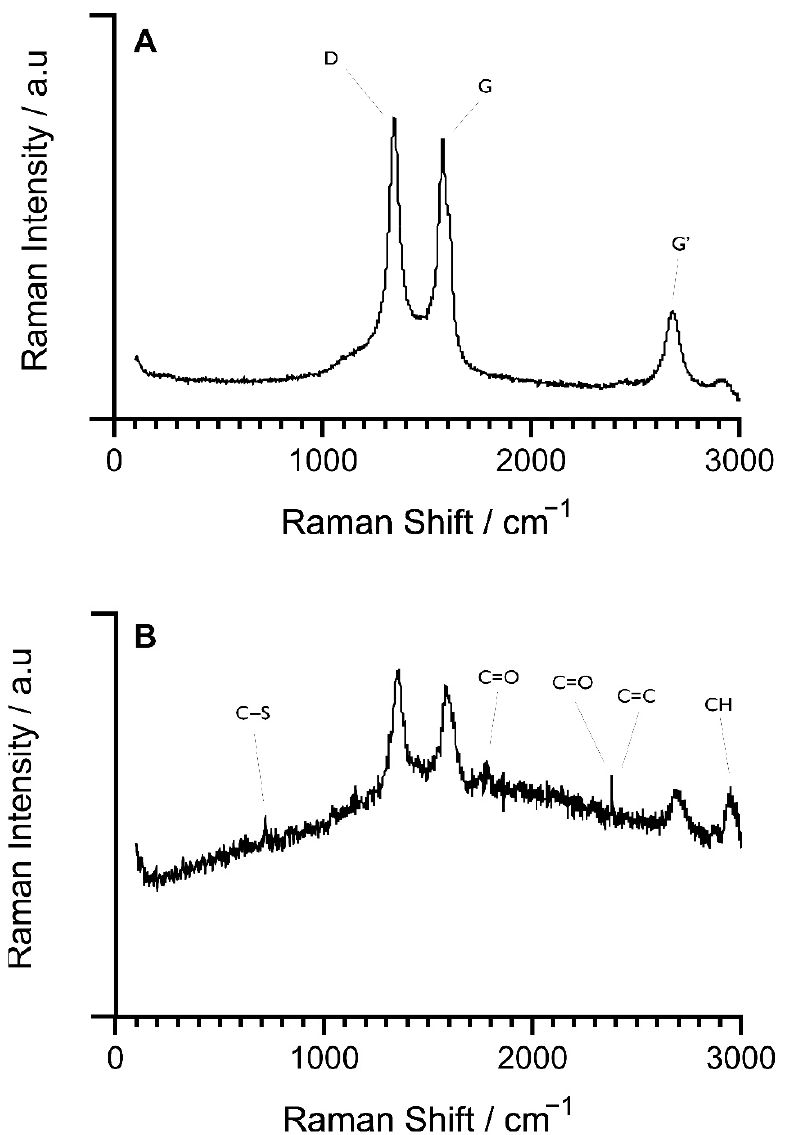
Figure 5. Raman spectroscopy of ( A ) bulk MWCNTs and ( B ) functionalised MWCNTs demonstrating the D (1350 cm − 1 ), G (1560 cm − 1 ), and G’ (2700 cm − 1 ) vibrational peaks representative of sp 2 carbon nanomaterials. Further peaks at 719 cm − 1 , 1783 cm − 1 , 2382 cm − 1 , 2387 cm − 1 , and 2947 cm − 1 were identified to be indicative of the MWNCT diamine oxidase functionalisation.